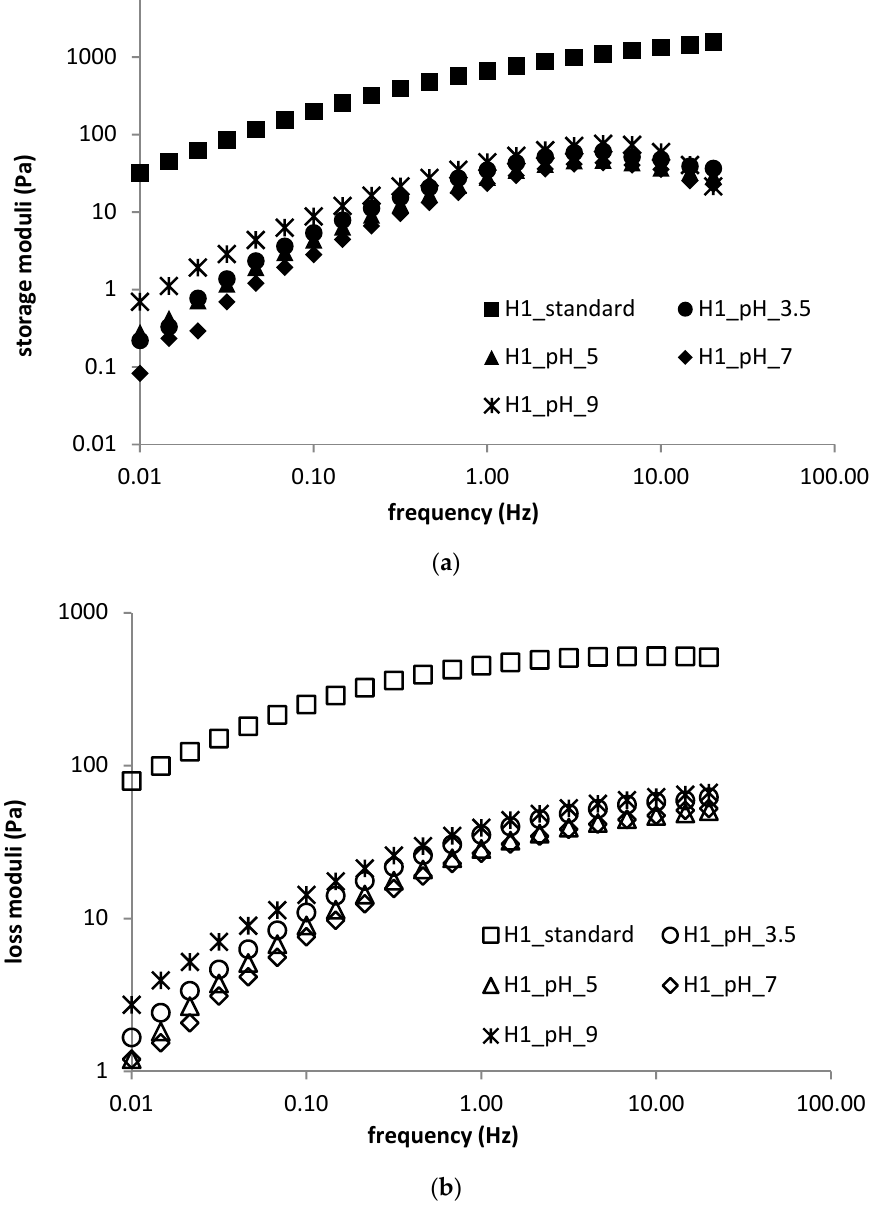
Figure 5. (a) Frequency sweep (storage moduli) for H1 sample—pH dependence; (b) frequency Figure 5. ( a ) Frequency sweep (storage moduli) for H1 sample—pH dependence; ( b ) frequency sweep sweep (loss moduli) for H1 sample—pH dependence (loss moduli) for H1 sample—pH